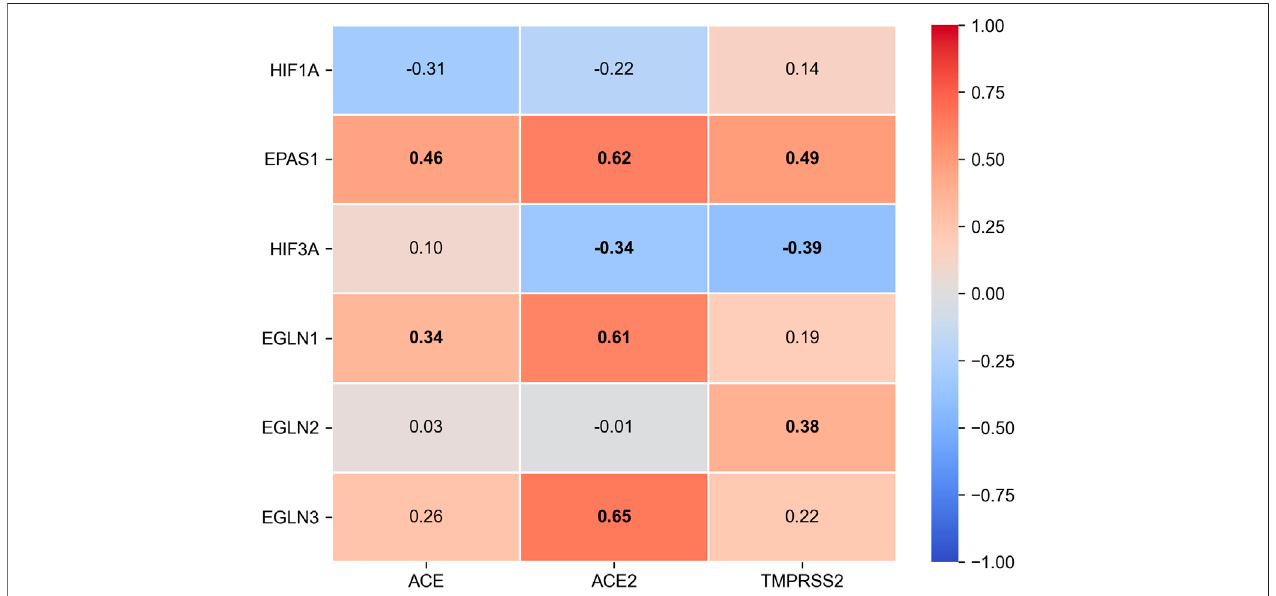
FIGURE4| Spearman ’ srankcorrelationmatrixbetweenHIFalphasubunits(HIF-1 α ,HIF-2 α encodedbyEPAS1,HIF-3 α ),HIFprolyl-hydroxylase isoforms(EGLN1 encodes PHD2, EGLN2 - PHD1, EGLN3 - PHD3) and ACE2 expression and TMPRSS2 expression in healthy intestinal tissues from TCGA-COAD dataset. RNA sequencing count data for n (cid:1) 38 normal samples were obtained from GDC Data Portal (https://portal.gdc.cancer.gov/) and converted to format of TMM-normalized Fragment Per kilobase of transcript per Million mapped reads (FPKM) with edgeR v3.30.3 (Robinson et al., 2010). Bold labels represent statistically signi fi cant correlation ( p <